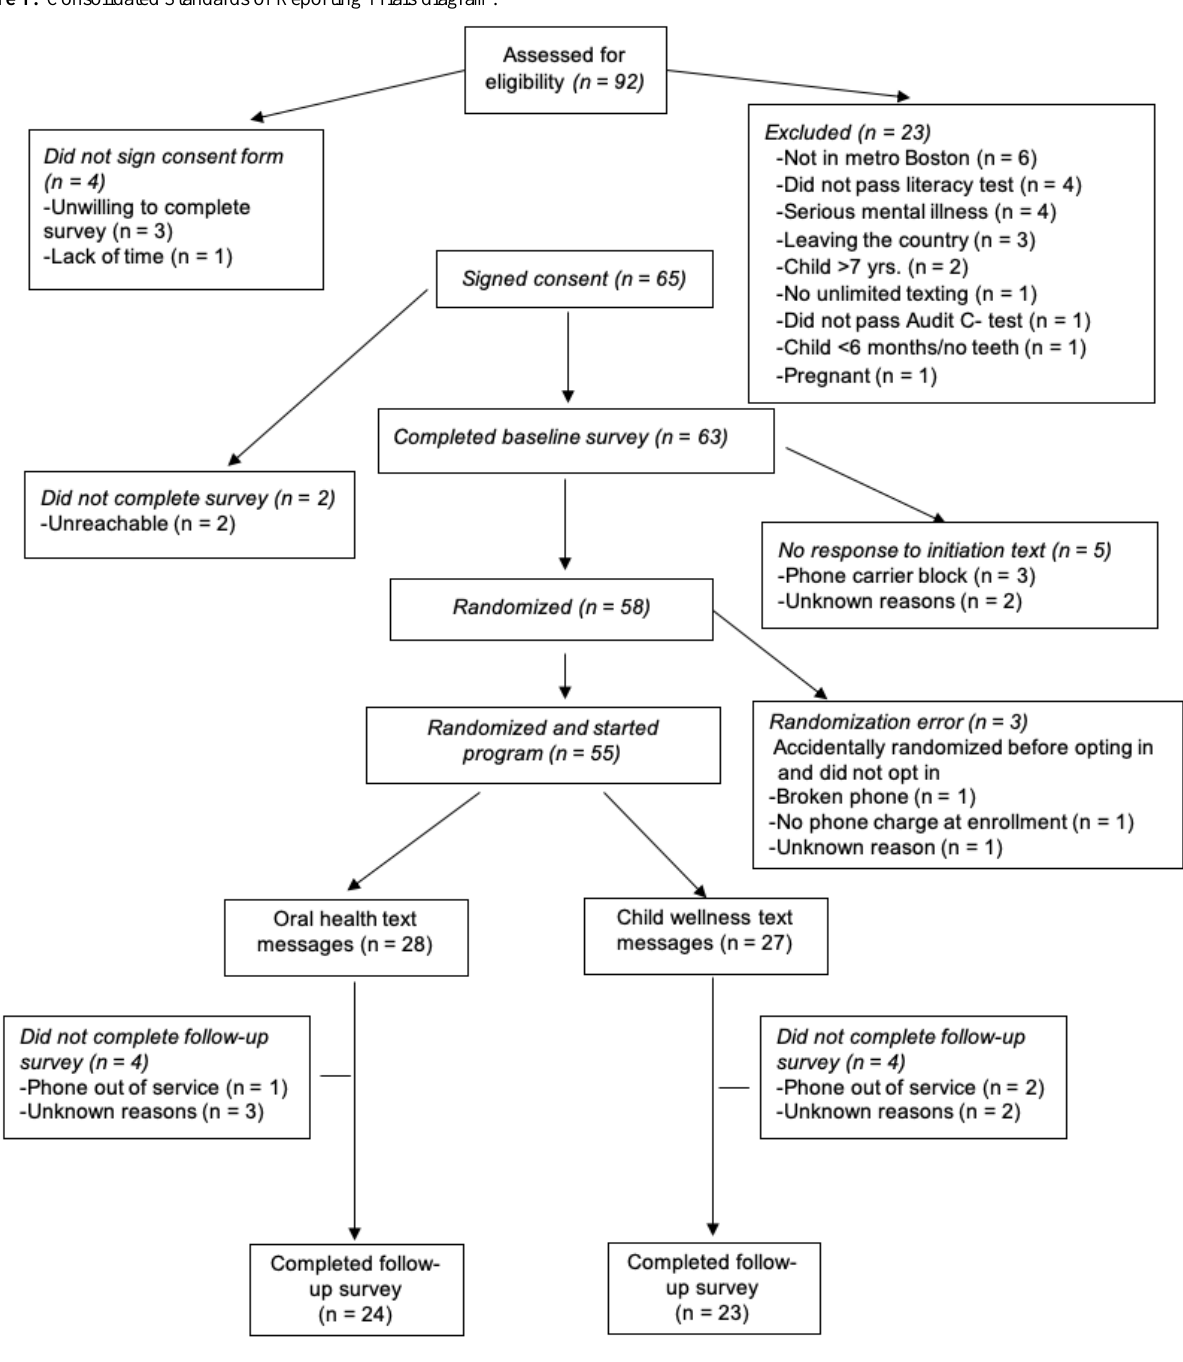
Figure 1. Consolidated Standards of Reporting Trials